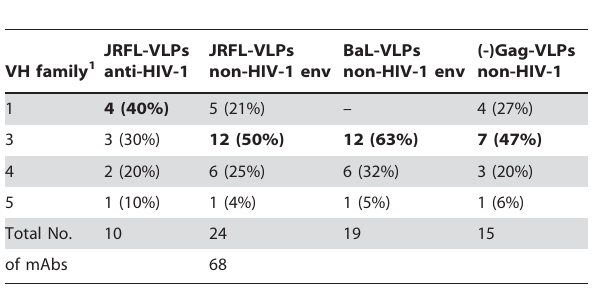
3c25 and 3c81, neutralized only three and two viruses, respectively (Table 3). These two anti-CD4bs mAbs displayed possibly lower affinity binding as they reacted with gp120 relatively weakly (Table 1, Fig. S1). Production of 68 mAbs from one infected individual, with different specificities to HIV-1 and non-HIV-1 Env antigens, allowed for the comparison of the Ig variable genes usage by these two different panels of mAbs. Anti-HIV-1 Env mAbs selected by the JRFL-VLPs predominantly used VH1 family genes (four of ten mAbs used VH1 gene, 40%) over VH3 family genes (three of 10 Table 2. Biased usage of VH family genes by anti-HIV-1 mAbs produced from one infected